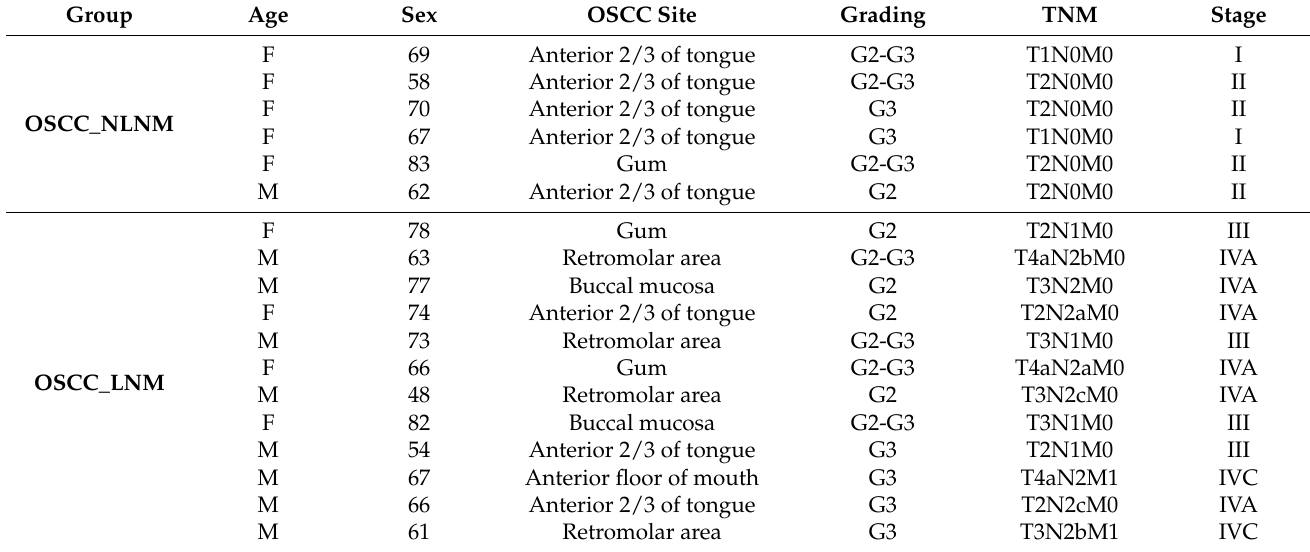
Table 2. OSCC site in NLNM and LNM